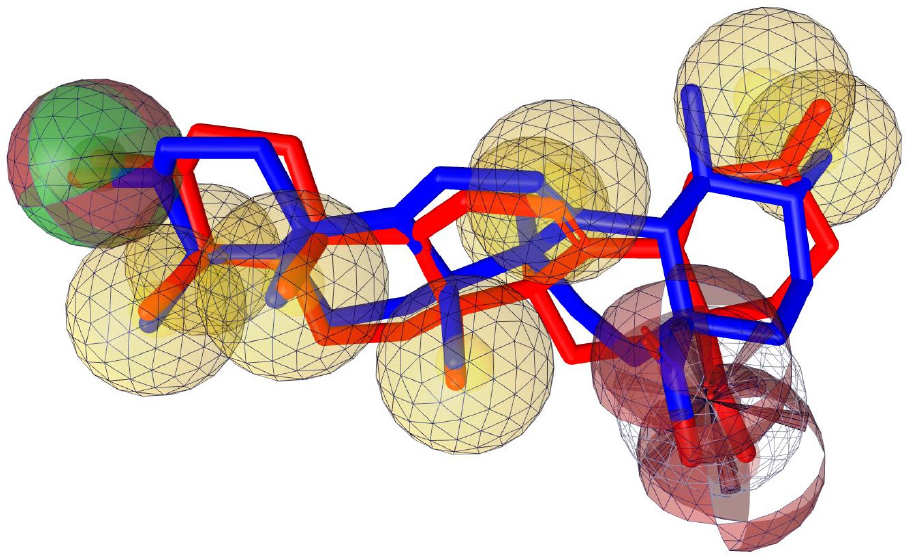
Figure 8. Common feature pharmacophore. Color codes analogous to Figure 7 Red, HBAs; green, HBDs; Yellow, H; Brown, NI.